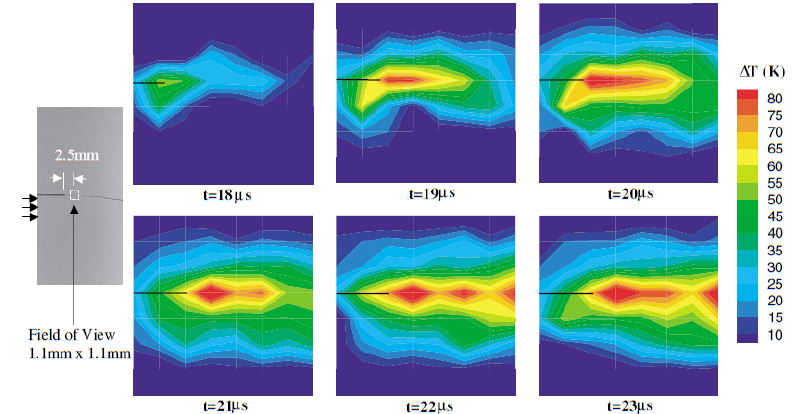
Figure 12. Highly transient two-dimensional temperature field within a well developed ASB (with permission of